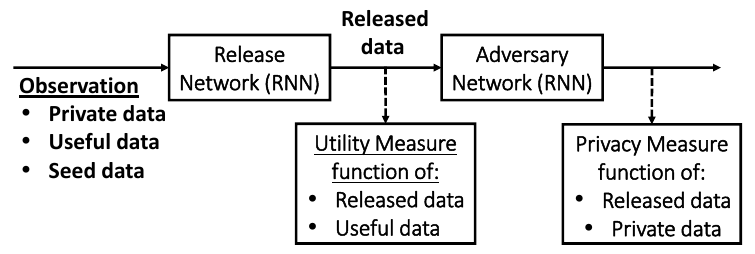
Figure 2. Diagram of privacy